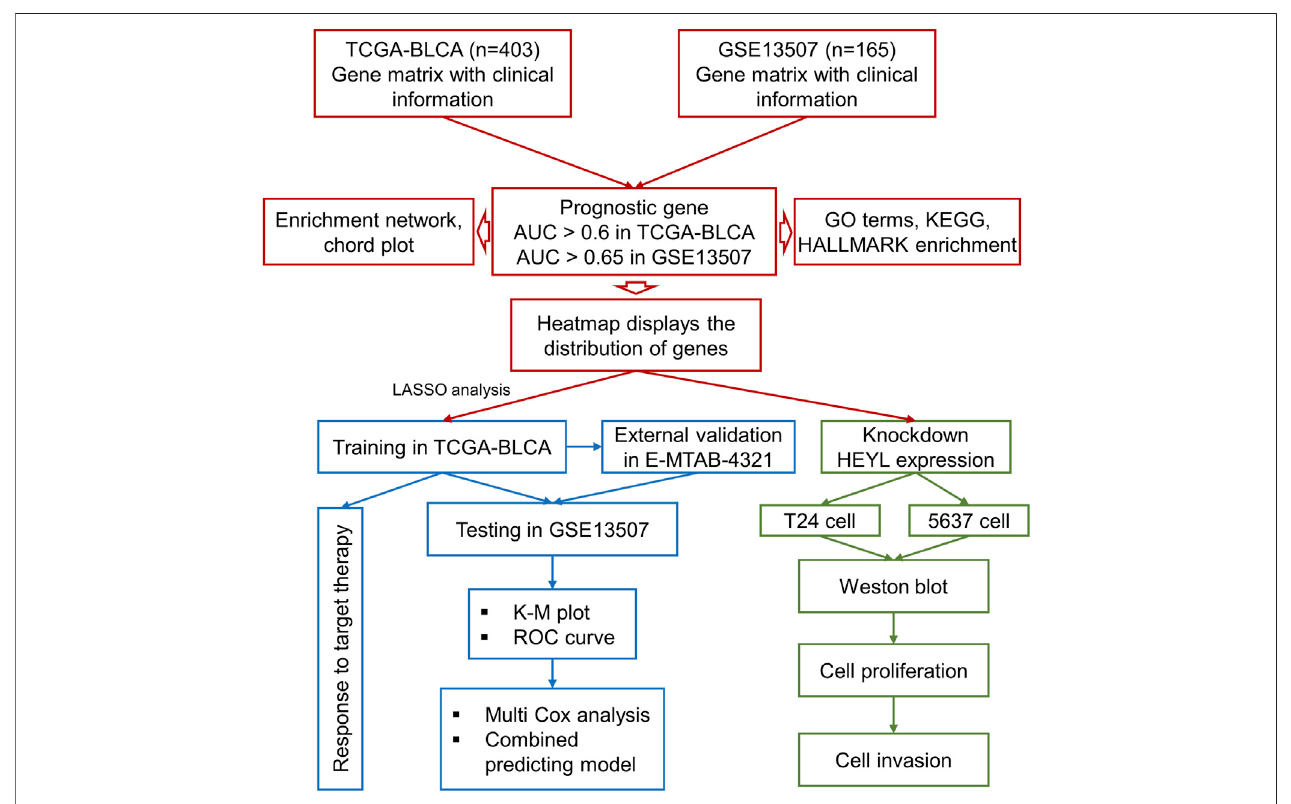
FIGURE 1 | The process of the current